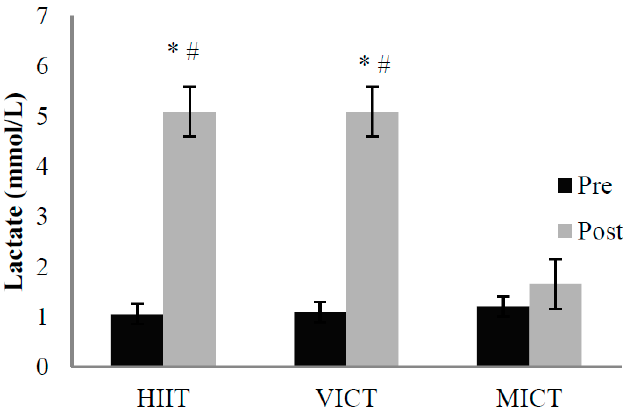
Figure 4 . Changes in Blood Lactate Concentrations. * p < 0.01 versus pre-exercise; # p < 0.01 versus MICT.